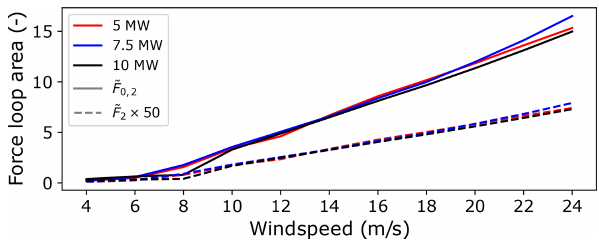
Figure 9. Non-dimensionalised, downwind-row, radial-load-loop- area results at various reference height wind speeds for overhung ( ˜ F 0 , 2 ) and centred ( ˜ F 2 ) main-bearing configurations across the three modelled turbines.